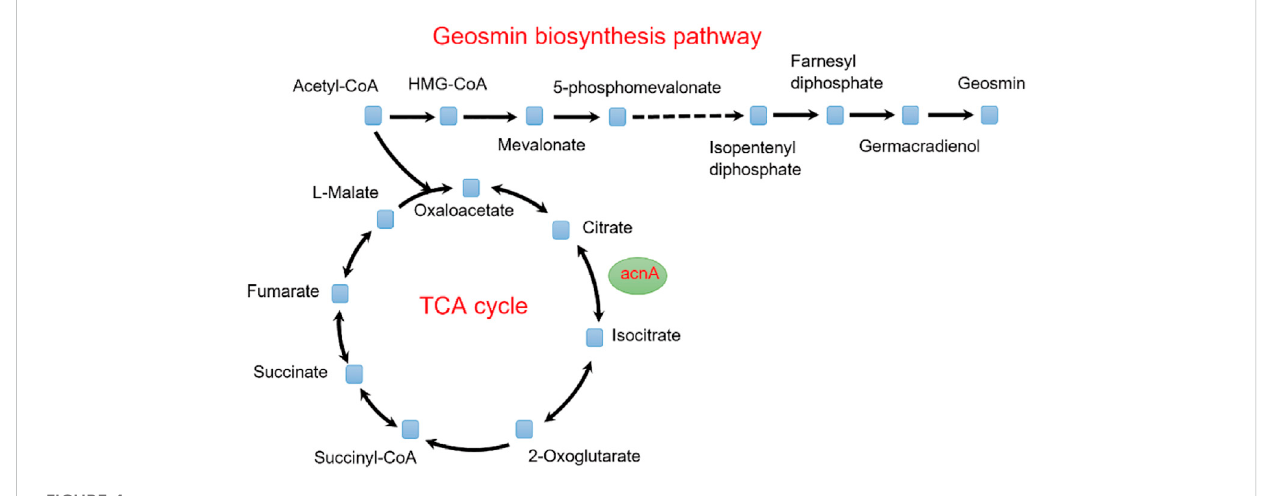
FIGURE 4 Effect of the TCA cycle on the synthesis of